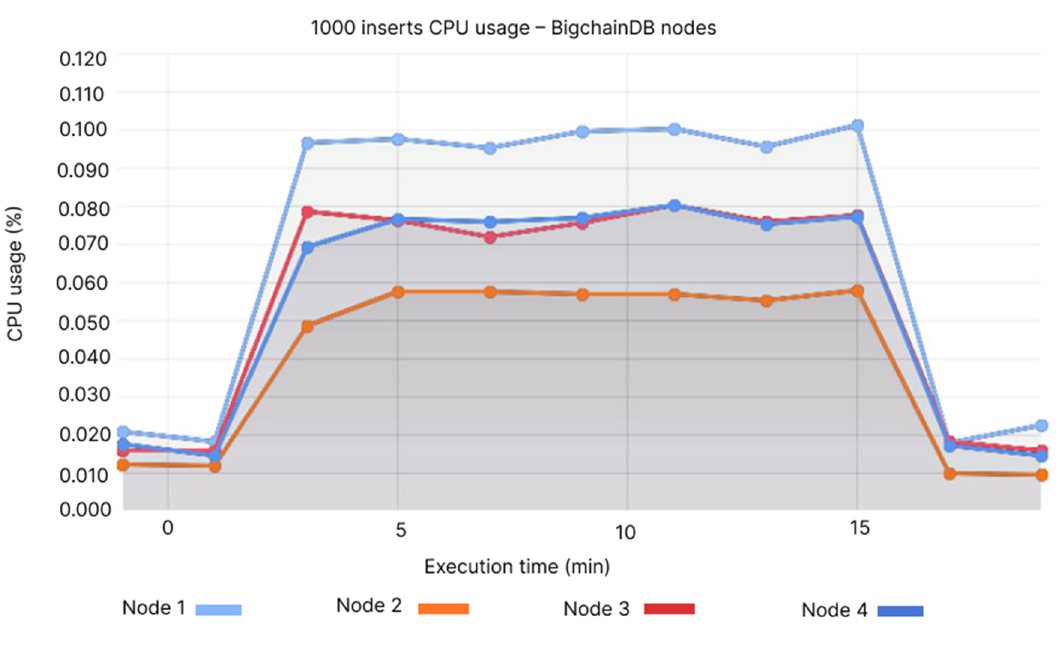
Figure 6. 1000 inserts CPU usage—BigchainDB nodes.